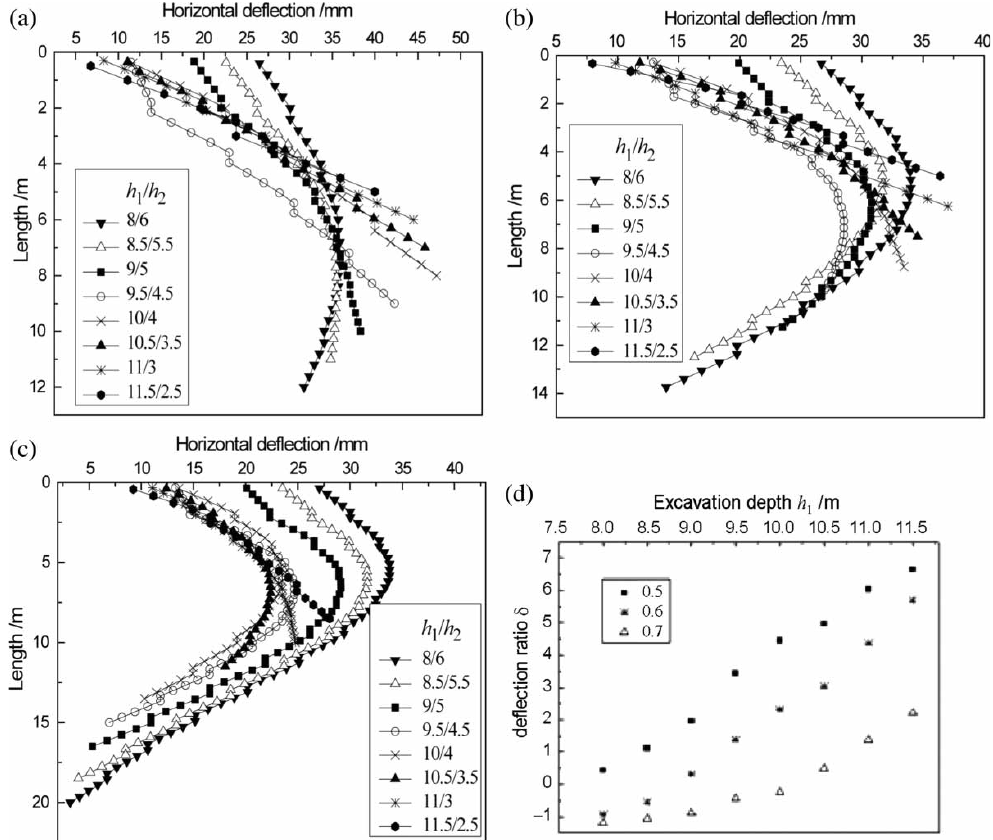
Fig. 10. Inner wall horizontal deflection at final excavation level for different embedment ratios of the inner support structure: (a) ratio of 0.5; (b) ratio of 0.6; (c) ratio of 0.7; (d) deflection ratio of inner wall for different embedding ratios of the inner support